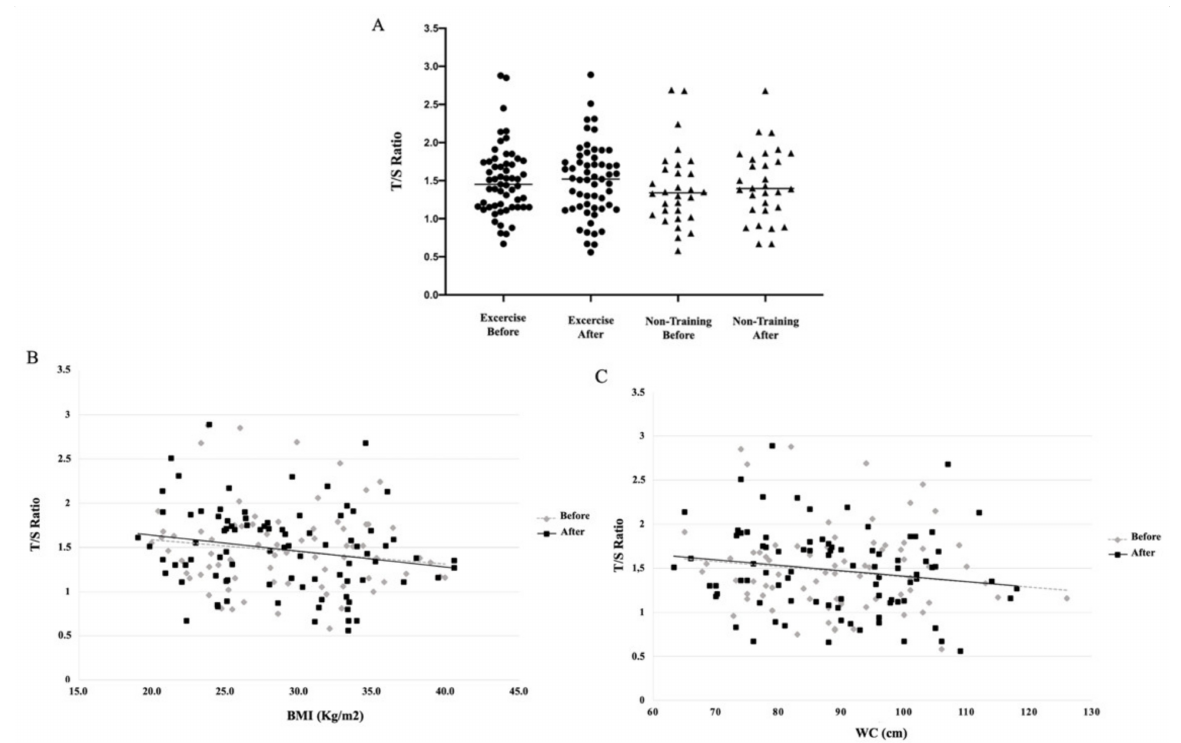
Figure 3. Telomere length (T/S ratio) before and after 16 weeks of aerobic physical training or observation period ( p > 0.05) ( A ). Spearman correlation between telomere length vs. BMI ( p = 0.0192) ( B ) and WC ( C ) ( p = 0.0334). CG, Control group; CAT, continuous aerobic training; IAT,